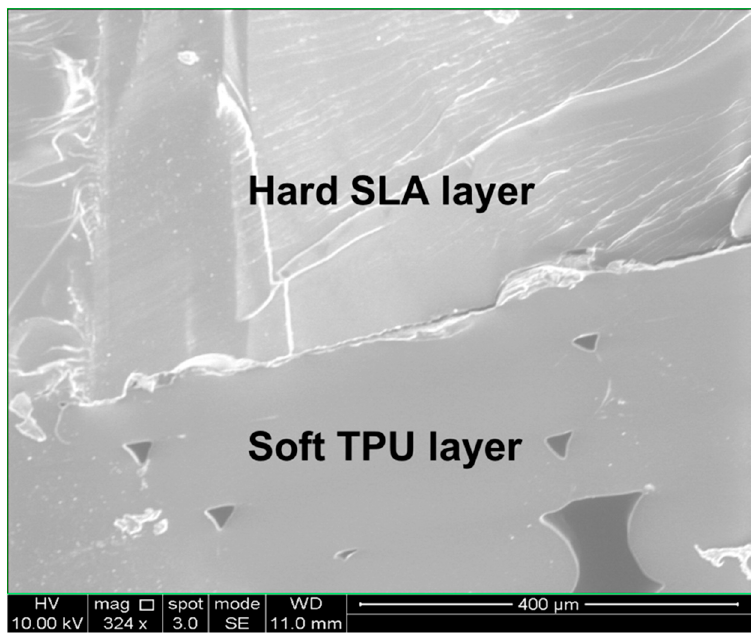
Figure 2. SEM image of the cross-section of the interface between the hard SLA-printed layer and soft TPU layer.